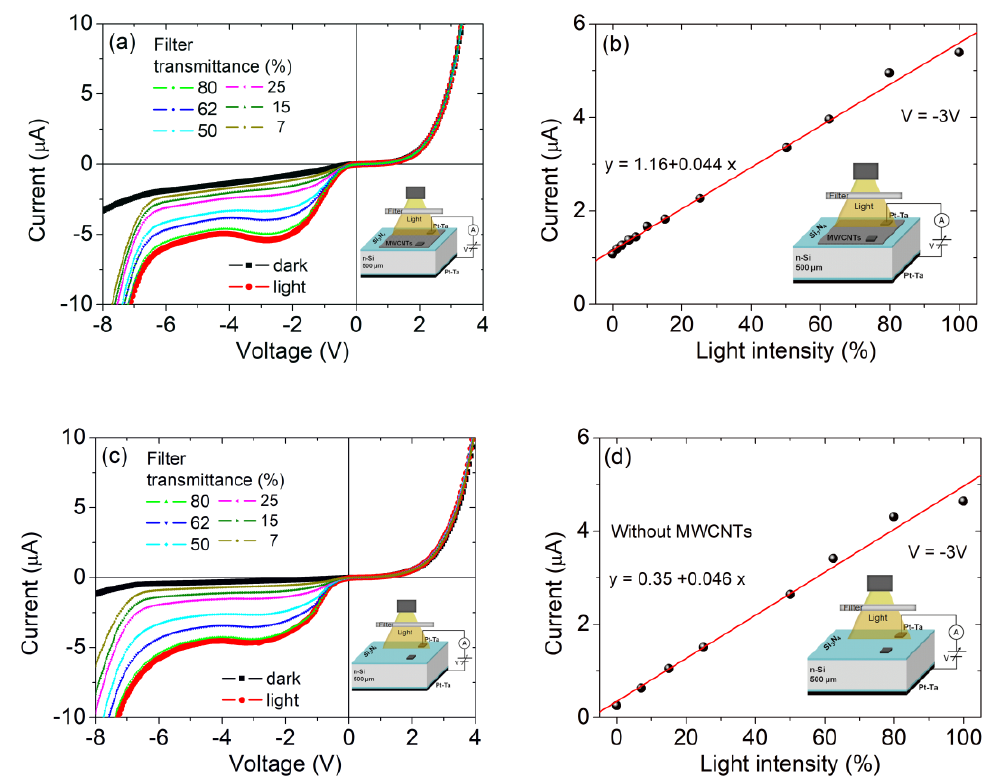
Figure 3. I-V characteristics and reverse current at –3 V as a function of the illumination intensity (percentage) of the Pt - Ta_CNT/Si 3 N 4 /n-Si/Si 3 N 4 /Pt - Ta ( a , b ) and Pt - Ta/Si 3 N 4 /n-Si/Si 3 N 4 /Pt - Ta ( c , d ) MISIM heterostructures.